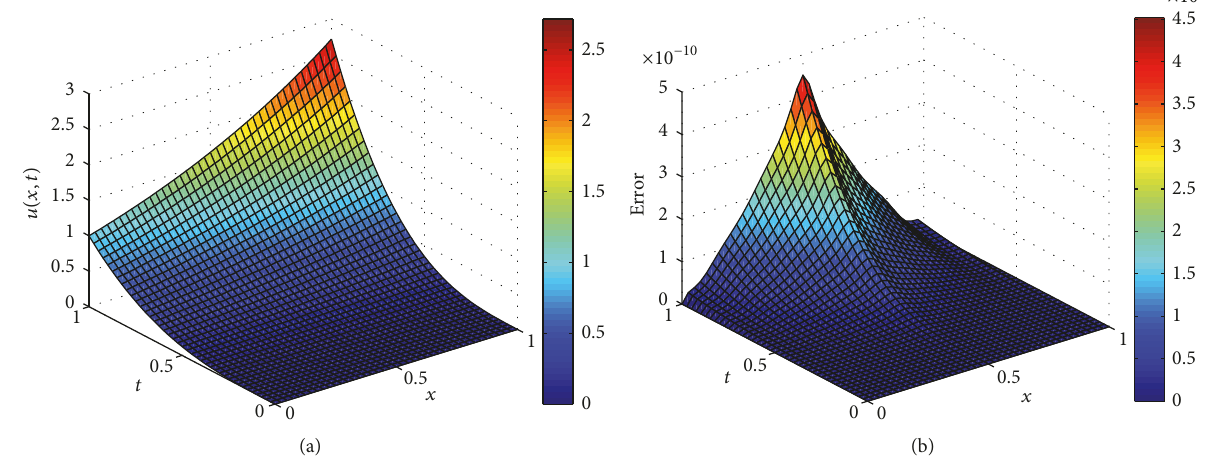
Figure 2: Approximate solution (a) and absolute error (b) for Example 2 with 𝛼 = 1.3 , 𝑘 = 2 , and 𝑀 = 6 .